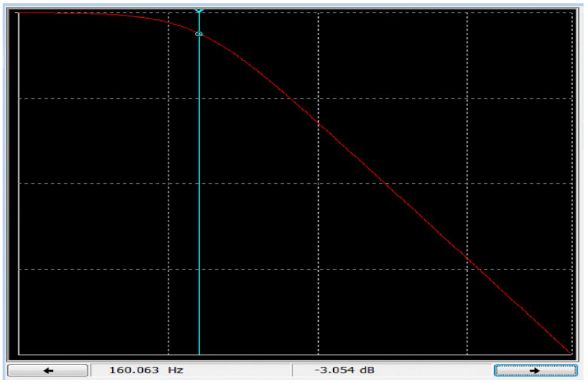
Fig. 13 Active HPF bode plot illustrates the cut-off frequency (50.025 m Hz ≅ 0.05 Hz)